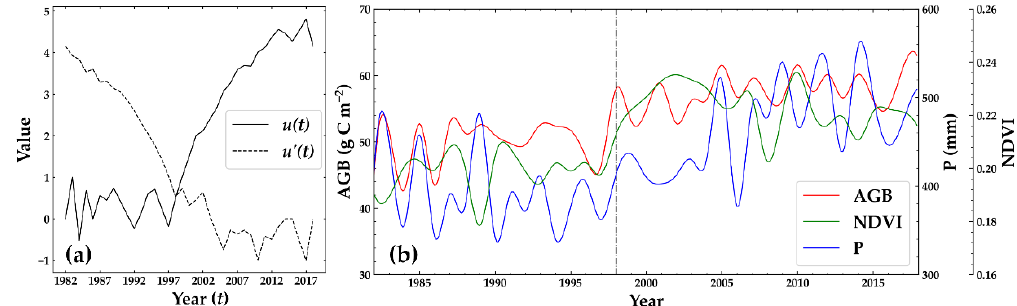
Figure 9. ( a ) Sequential Mann-Kendall test rank statistics for annual AGB; ( b ) interannual variability in AGB, NDVI, and P in the TRHR during 1982–2018. The black dotted line is the turning point of AGB temporal variation found by the sequential Mann-Kendall test.